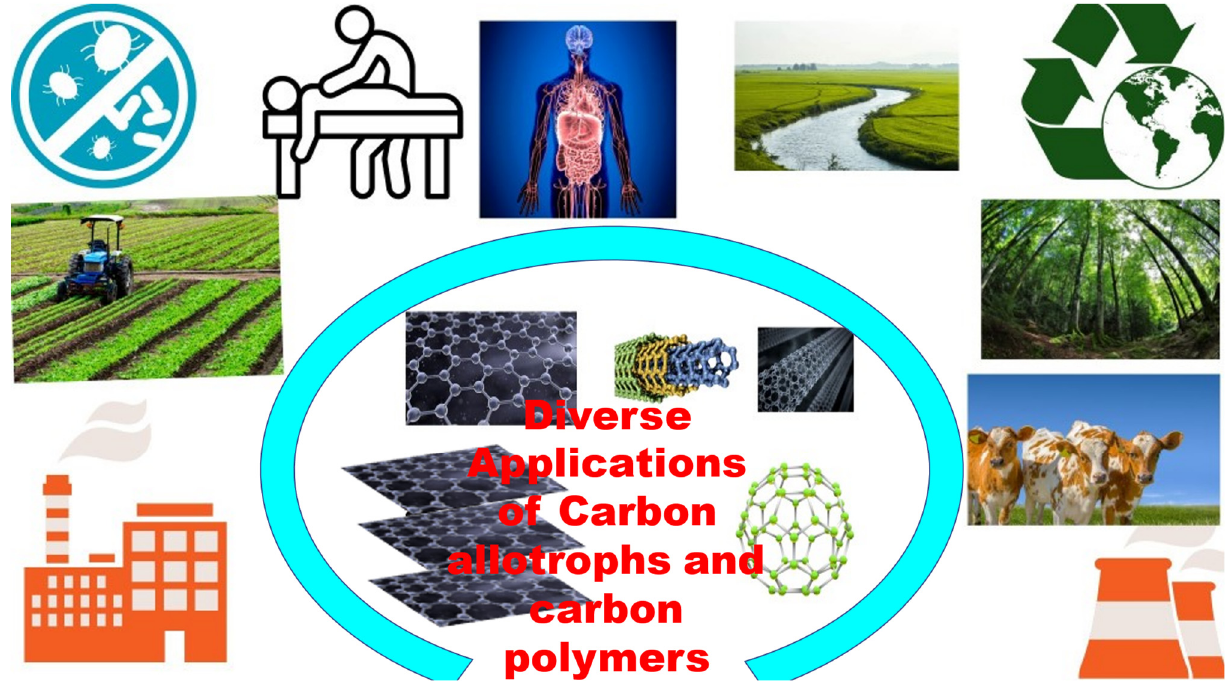
Figure 2. The varied applications where carbon allotrophs and carbon polymers are exploited.